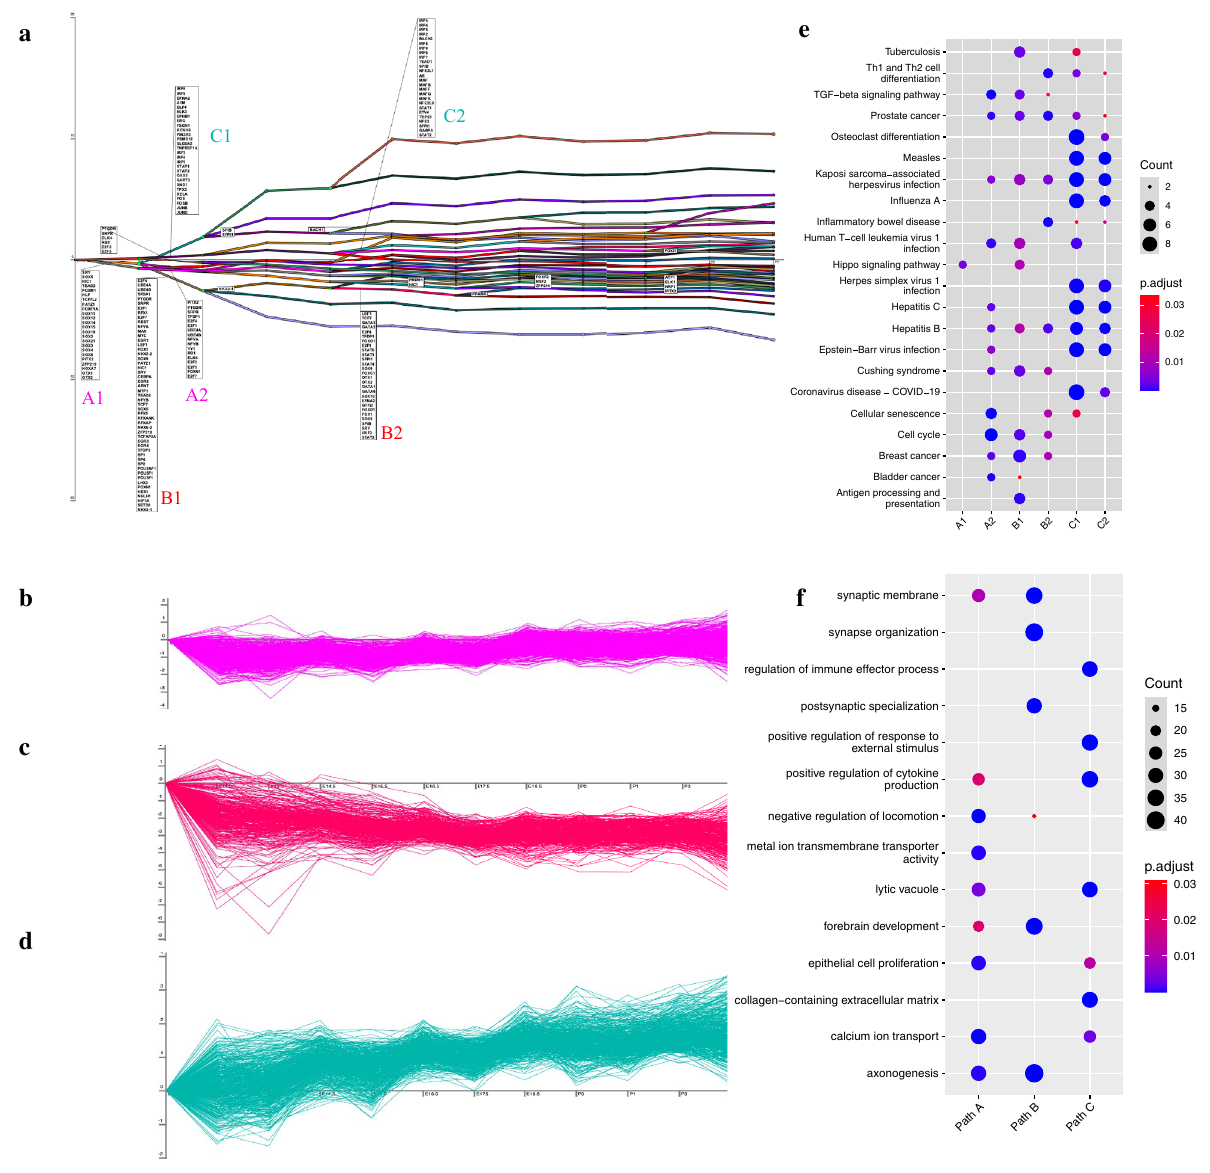
Figure 5. Temporal transcriptional regulatory map using DREM2. ( a ) Major dynamic regulatory paths during inner ear development. The x-axis denotes time points, the y-axis denotes the gene expression level relative to E11.5. Six key TF groups labelled as A1, A2, B1, B2, C1, C2; ( b ) Temporal expression pattern of TFs targeted genes of path A. ( c ) Temporal expression pattern of TFs targeted genes of path B. ( d ) Temporal expression pattern of TFs targeted genes of path C. ( e ) Enriched KEGG pathways for TFs. Full enrichment results can be found in Supplementary Data S10. ( f ) Enriched GO terms for genes in path A, B, C. Full enrichment result can be found in Supplementary Data